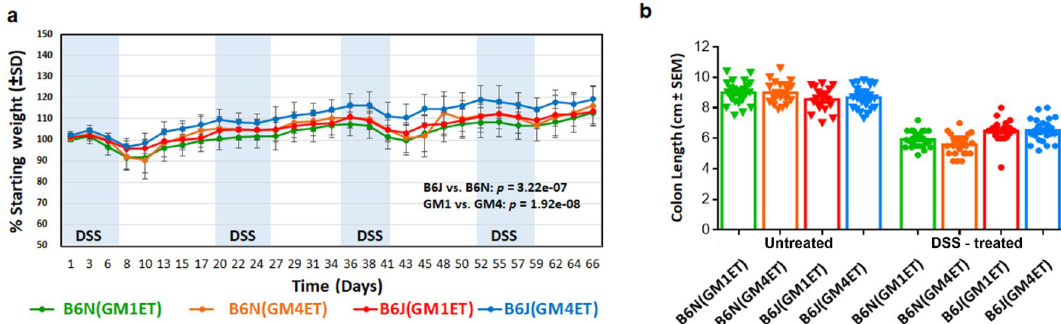
Figure 3. Influence of substrain genetics of recipient and the donor GM on the susceptibility to DSS-induced colitis in mice derived by embryo transfer. ( a) Comparison of DSS-induced weight change between substrains that received GM1 and GM4 via embryo transfer. Statistical analysis revealed the significant main effects of substrain (B6J vs. B6N: p = 3.22e-07), GM (GM1 vs. GM4: p = 1.92e-08), time ( p = 9.38e-90), and DSS treatment ( p = 1.71e-35) with an interaction of time and DSS treatment, p = 1.52e-12). The longitudinal measurements of each mouse were considered. A random intercept mixed effect model with AR covariance structure was performed for statistical analysis. ( b) Comparison of colon lengths revealed a significant main effect of treatment ( p < 2e-16, F = 546.38). While there was not a main effect of GM (ANOVA), visual inspection of the data showed that untreated B6N mice had longer colon lengths than untreated B6J mice but shorter colon lengths after DSS treatment.